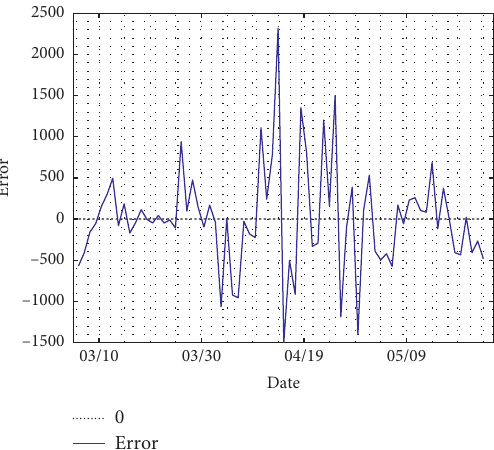
Figure 12: The fitting error of America with a mean absolute error of